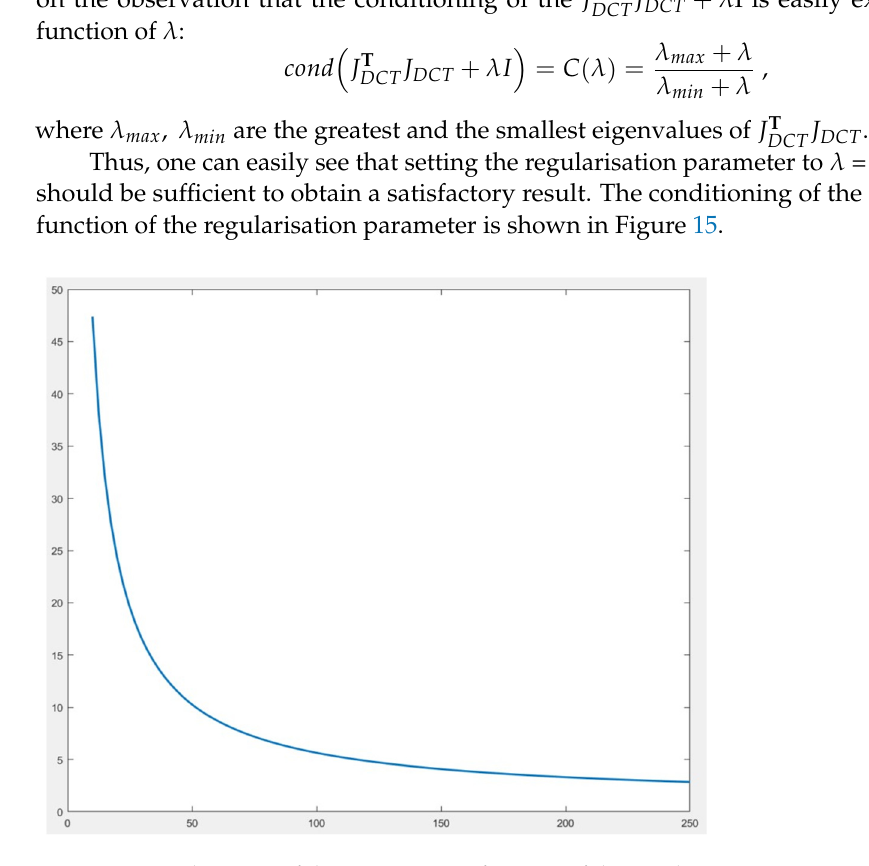
Figure 15. Conditioning of the equation as a function of the regularisation parameter.